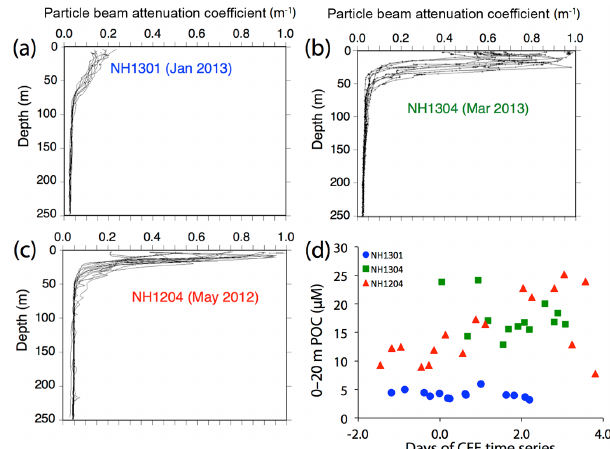
Figure A2. Panels (a–c) : particle beam attenuation coefficient ( c p ) profiles corresponding to NH1301 (January 2013), NH1304 (March 2013), and NH1204 (May/June 2012) expeditions. Panel (d) : POC calculated for the 0–20m depth interval using c p multiplied by 27. The x axis shows days relative to the start of each CFE